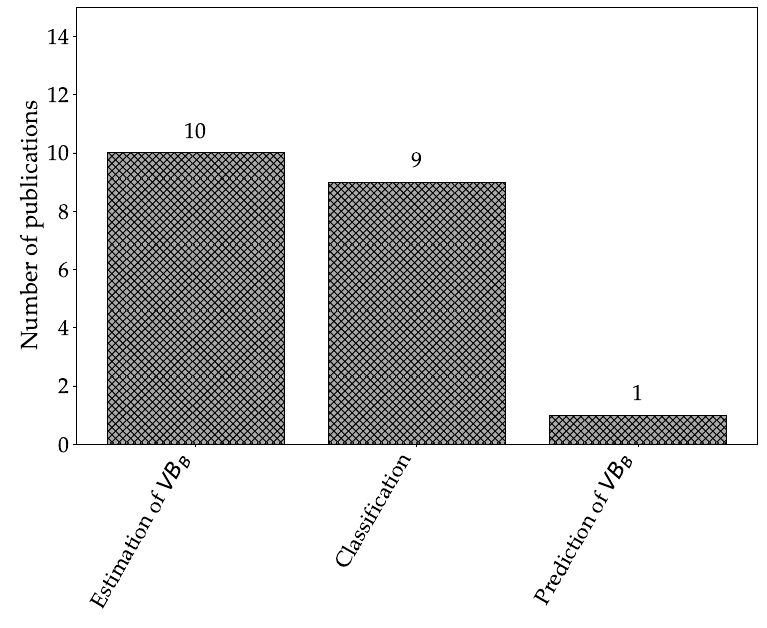
Figure 17. Repartition of SVM